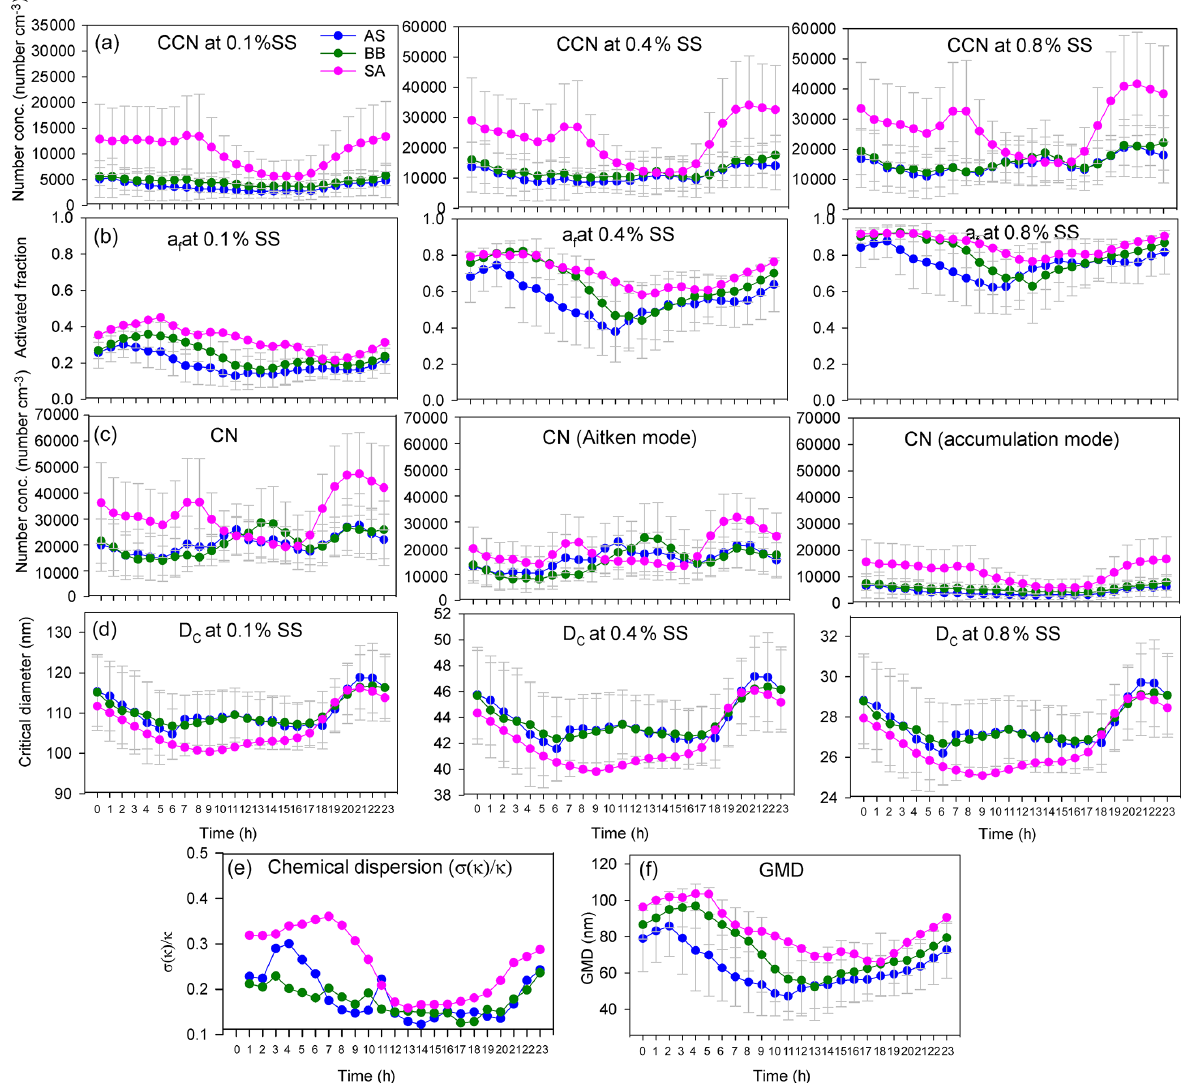
Figure 6. Diurnal variation in (a) N CCN at 0.1%, 0.4%, and 0.8% SS; (b) a f at 0.1%, 0.4%, and 0.8% SS; (c) N CN , N Aitken , and N Accumulation ; (d) D c at 0.1%, 0.4%, and 0.8% SS; (e) chemical dispersion; and (f) GMD for AS, BB, and SA air masses.